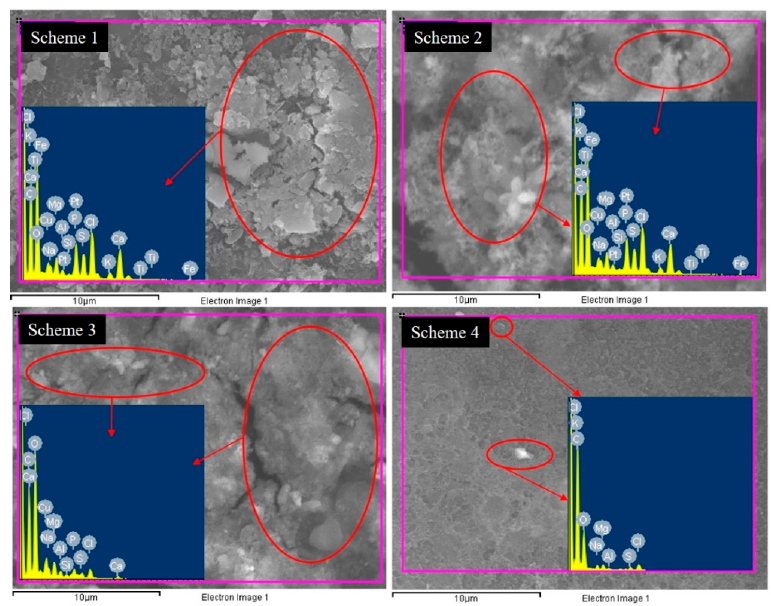
Figure 6. The elemental composition of the scale deposited on the membrane surfaces.